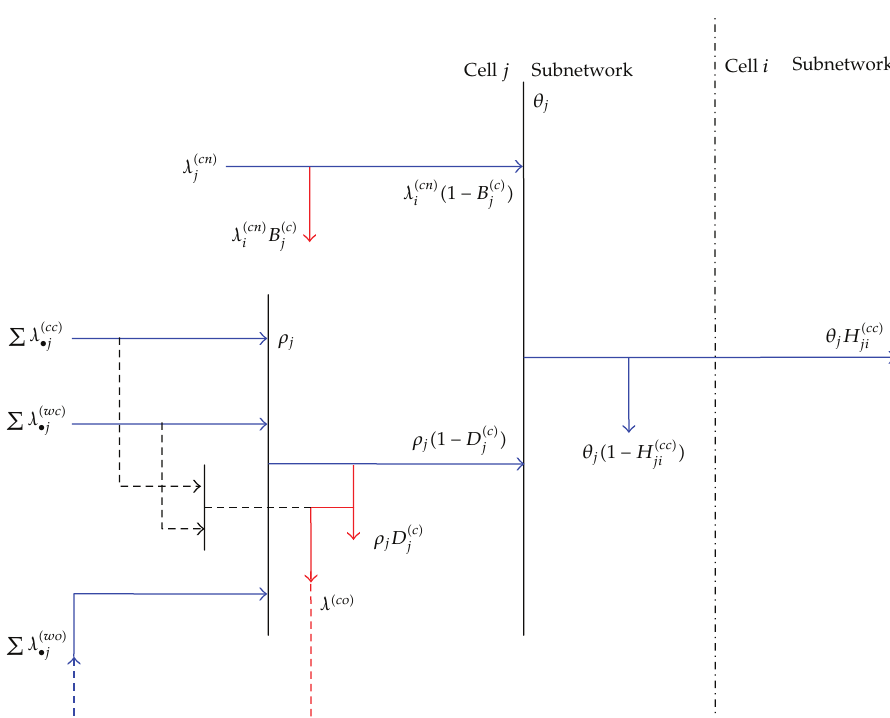
Figure 3: Horizontal handover tra ffi c between cellular